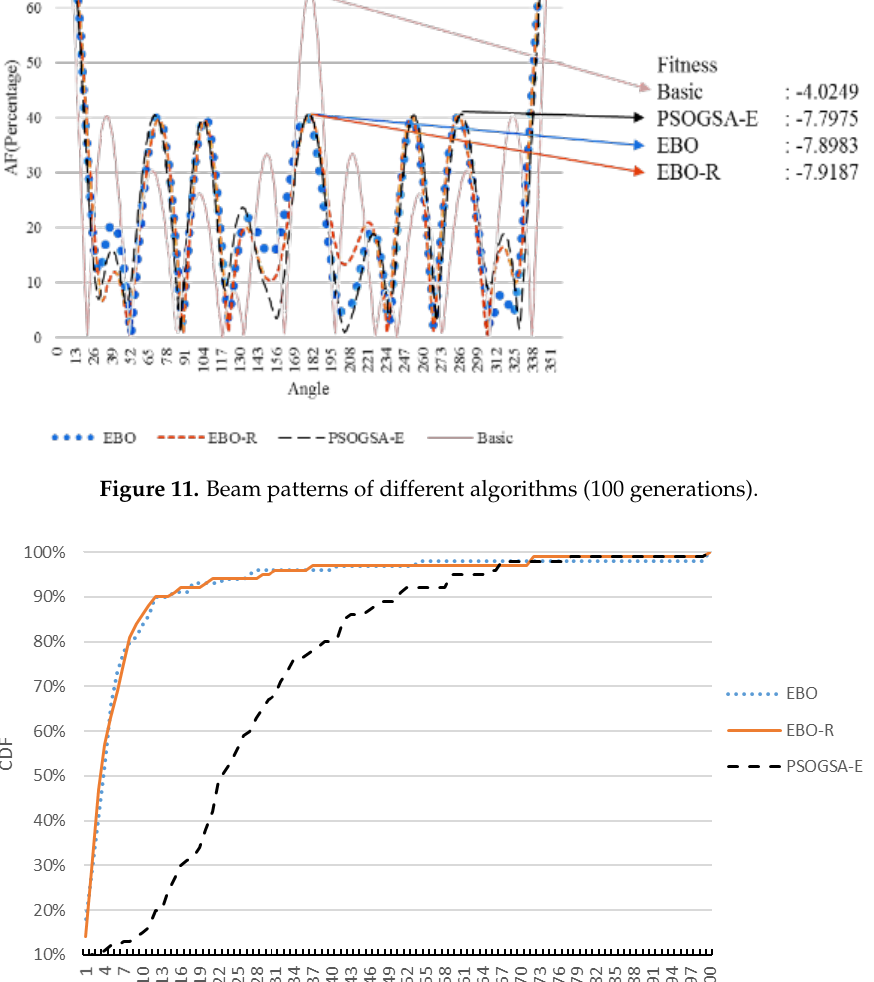
Figure 11. Beam patterns of different algorithms (100 generations).